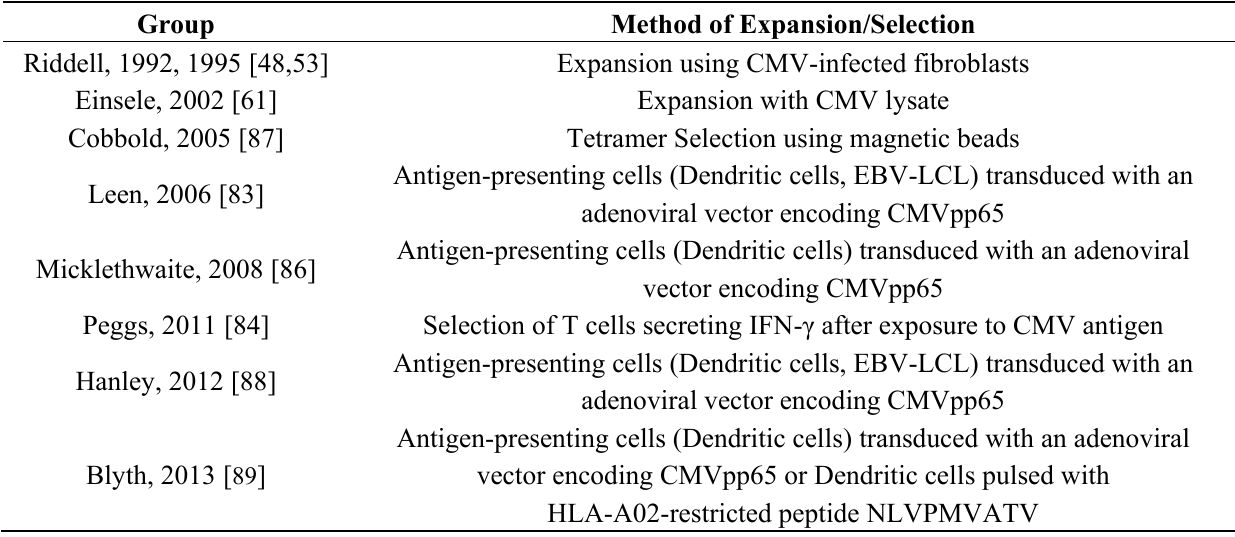
Table 2. Studies of adoptively transferred CMV-specific T